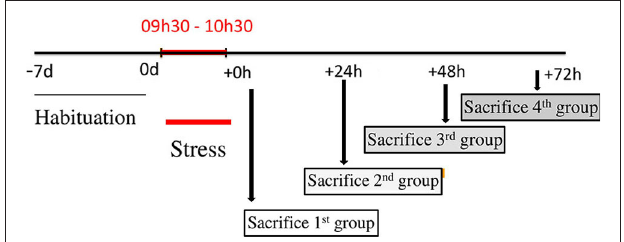
FIGURE 1 | Design of stress procedures . This figure represents a schematic presentation with a time-line of treatment schedule. Before stress procedure, a period of habituation is planned to minimize any external influences. Food intake (FI) and body weight (BW) for each rat, were monitored daily during this period. After, 20 rats were immobilized for 1 h and divided into four groups. The first group was sacrificed just after the cessation of stress and corresponds to 0 h group. The second, the third and the fourth groups were sacrificed at 24, 48 and 72 h after the end of immobilization respectively and correspond to 24, 48 and 72 h groups. FI and BW are monitored just before the decapitation for each group.